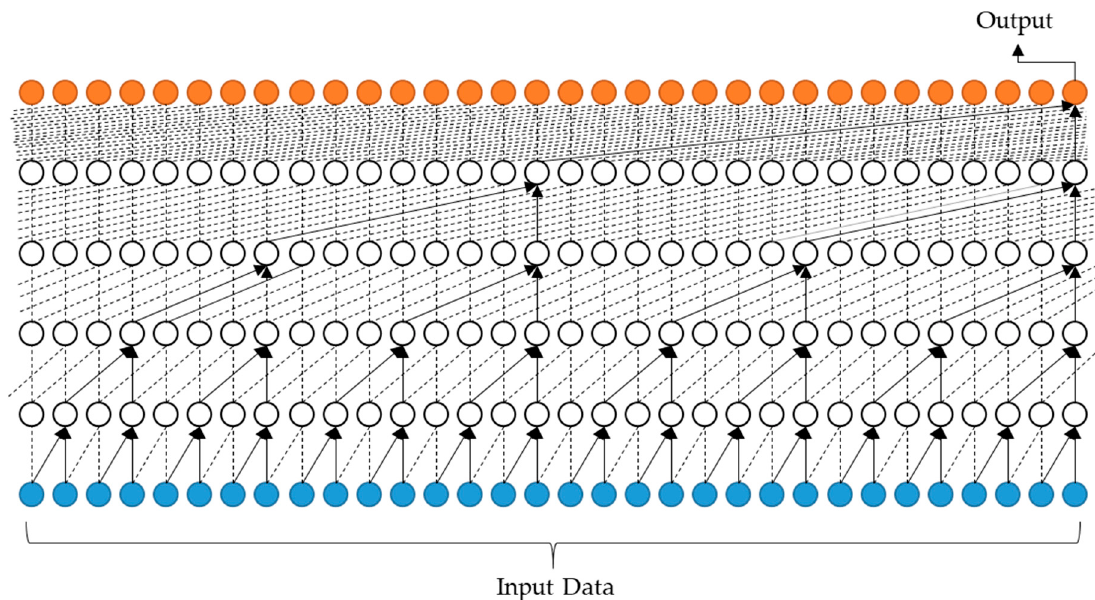
Figure 4. Dilated causal convolutional neural network with filter size 2.